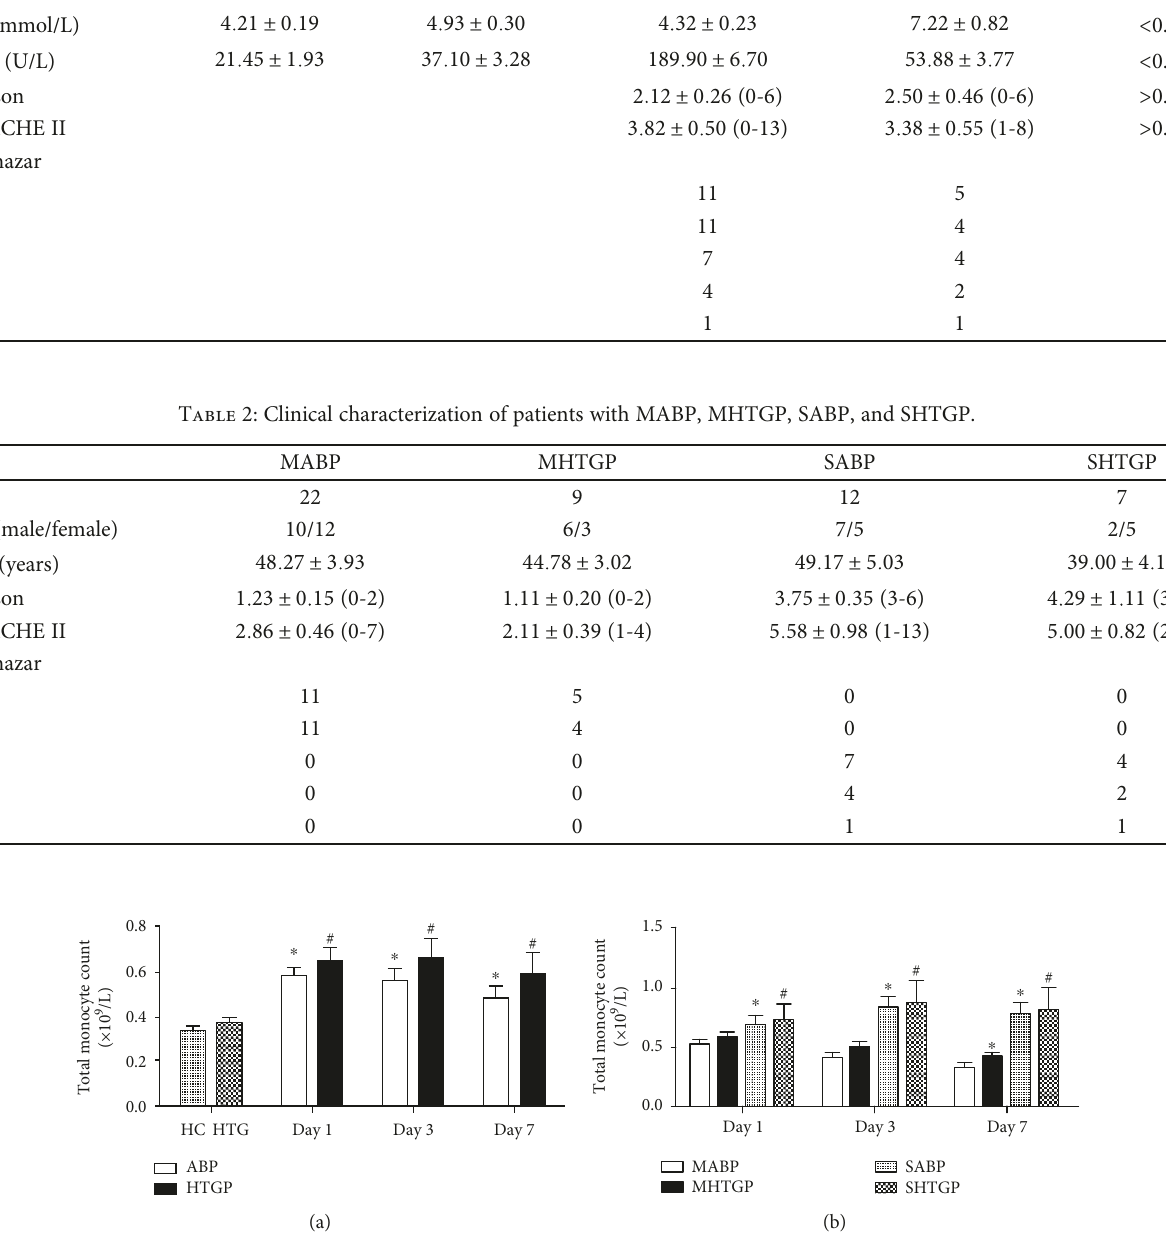
Figure 1: Peripheral blood total monocyte count in all subjects on days 1, 3, and 7. ∗ P < 0 05 compared with HC group (a) or MABP group (b). # P < 0 05 compared with HTG group (a) or MHTGP group (b).